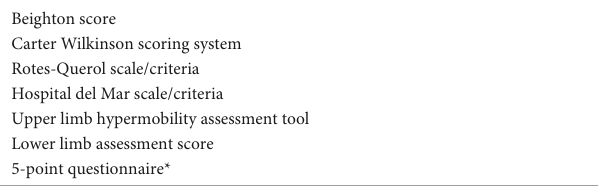
TABLE 1 Assessment of generalized joint hypermobility (17,